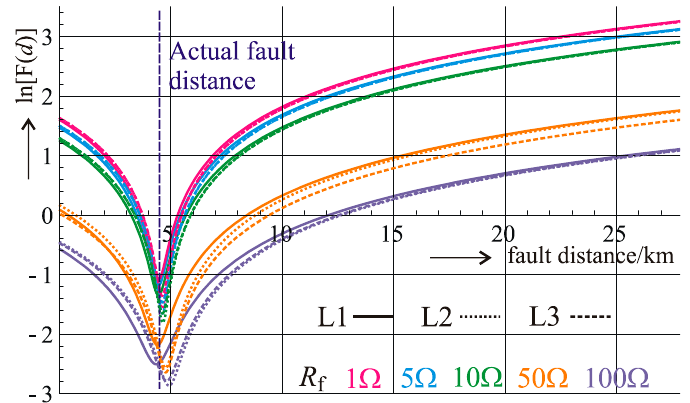
Figure 10. The line asymmetry impact on the fault location calculation.